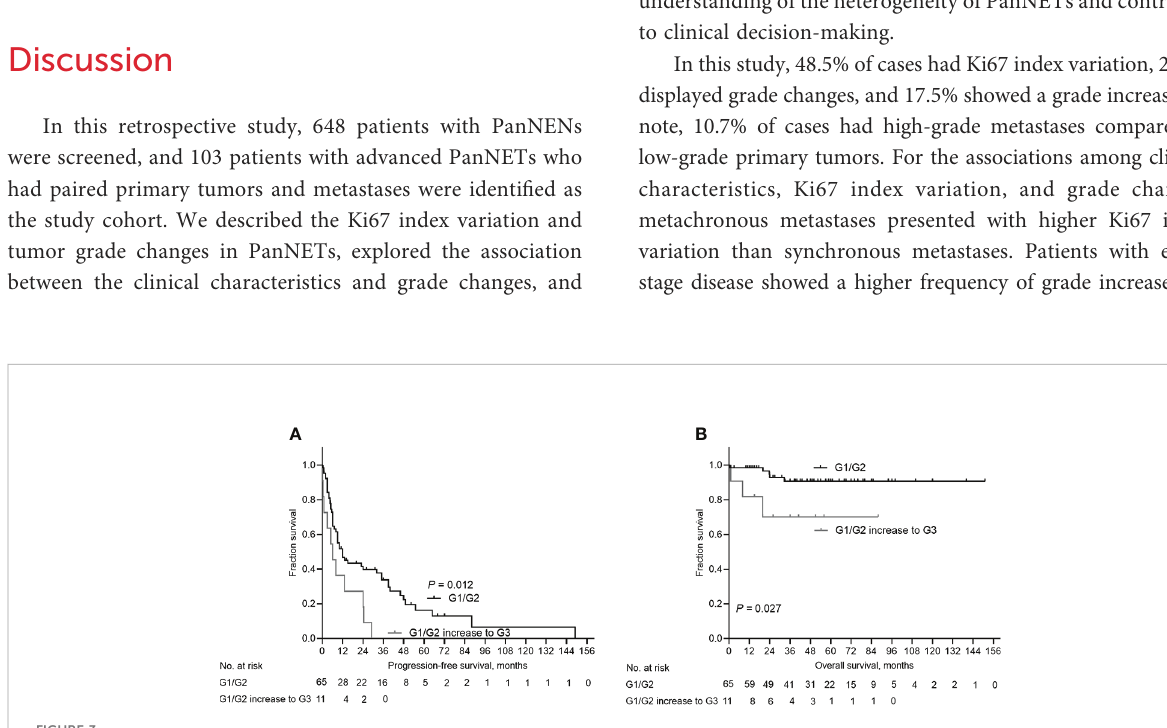
FIGURE 3 Kaplan-Meier curves depicting progression-free survival (PFS) and overall survival (OS) for patients G1/G2 increase to G3. (A) Patients with G1/G2 increase to G3 had decreased PFS than patients with stable G1/2 ( P =0.012). (B) Patients with G1/G2 increase to G3 had decreased OS than patients with stable G1/2 ( P =0.027).